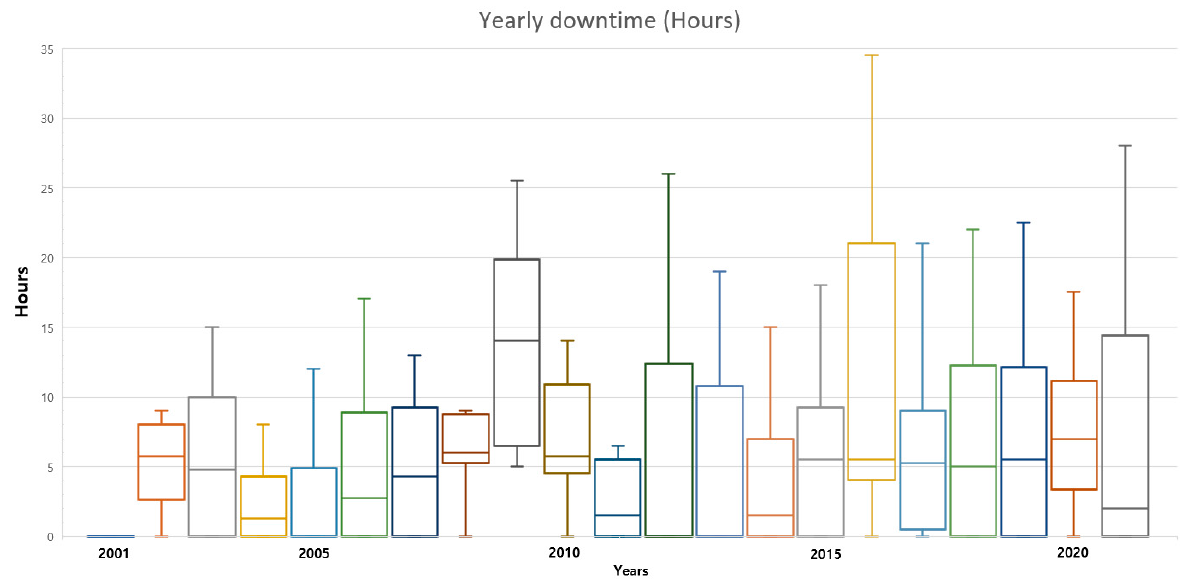
Figure 3. Annual downtime analysis from 2001 to 2021. In this period, excluding 2009 and 2016, the average downtime was 63 h ± 20.98. The downtime increased for years when replaced parts took longer to supply and needed complex QA procedures, e.g., 2009 IQR [(median:14, Q1:6.5, Q3:19.88) (5–25.5)].